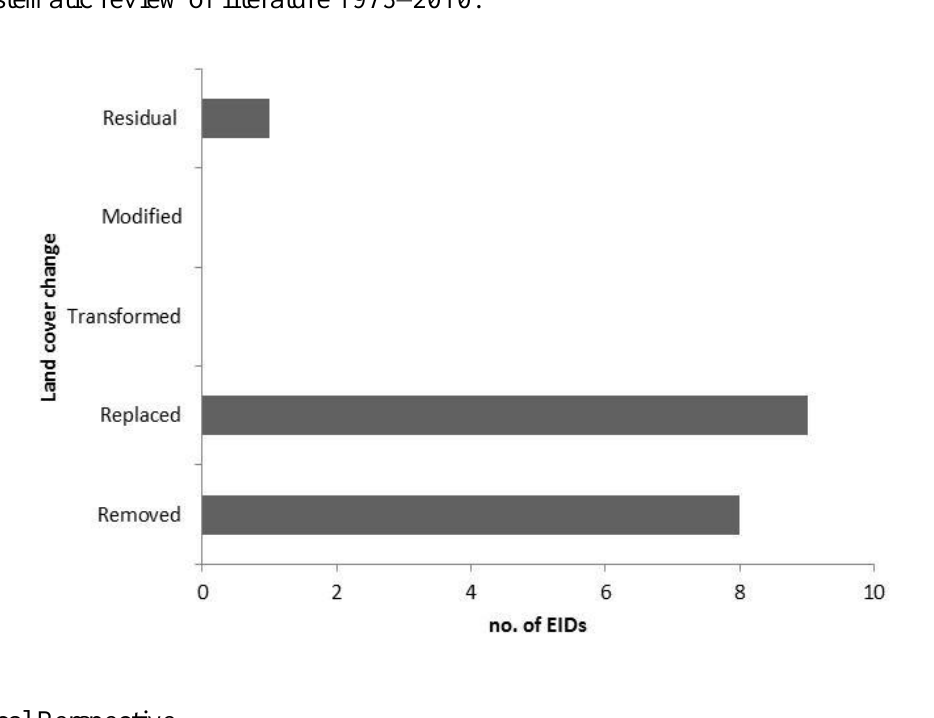
Figure 2. Land cover change: emerging infectious disease associations in Australia based on a systematic review of literature